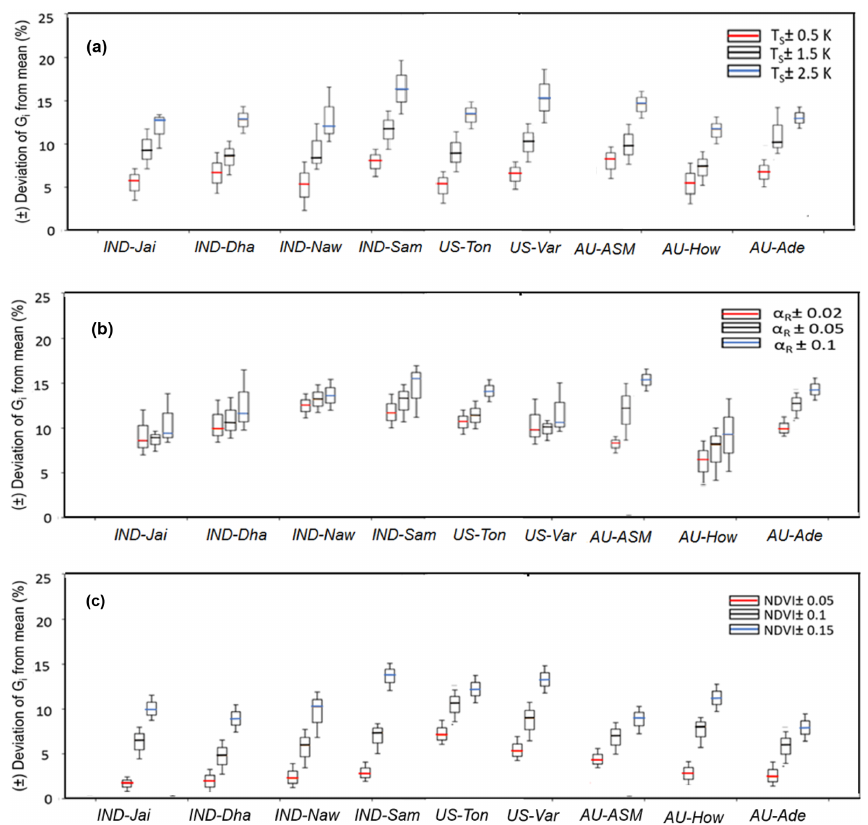
Figure 6. Sensitivity of STIC-TI G i due to uncertainties in T S (a) , α R (b) , and NDVI (c) for nine flux tower sites in India, the United States, and Australia. The uncertainties were introduced by taking the mean values of these variables during three different periods (summer, rainy, and winter) of a year. Mean uncertainties of the three periods are presented in the figure.